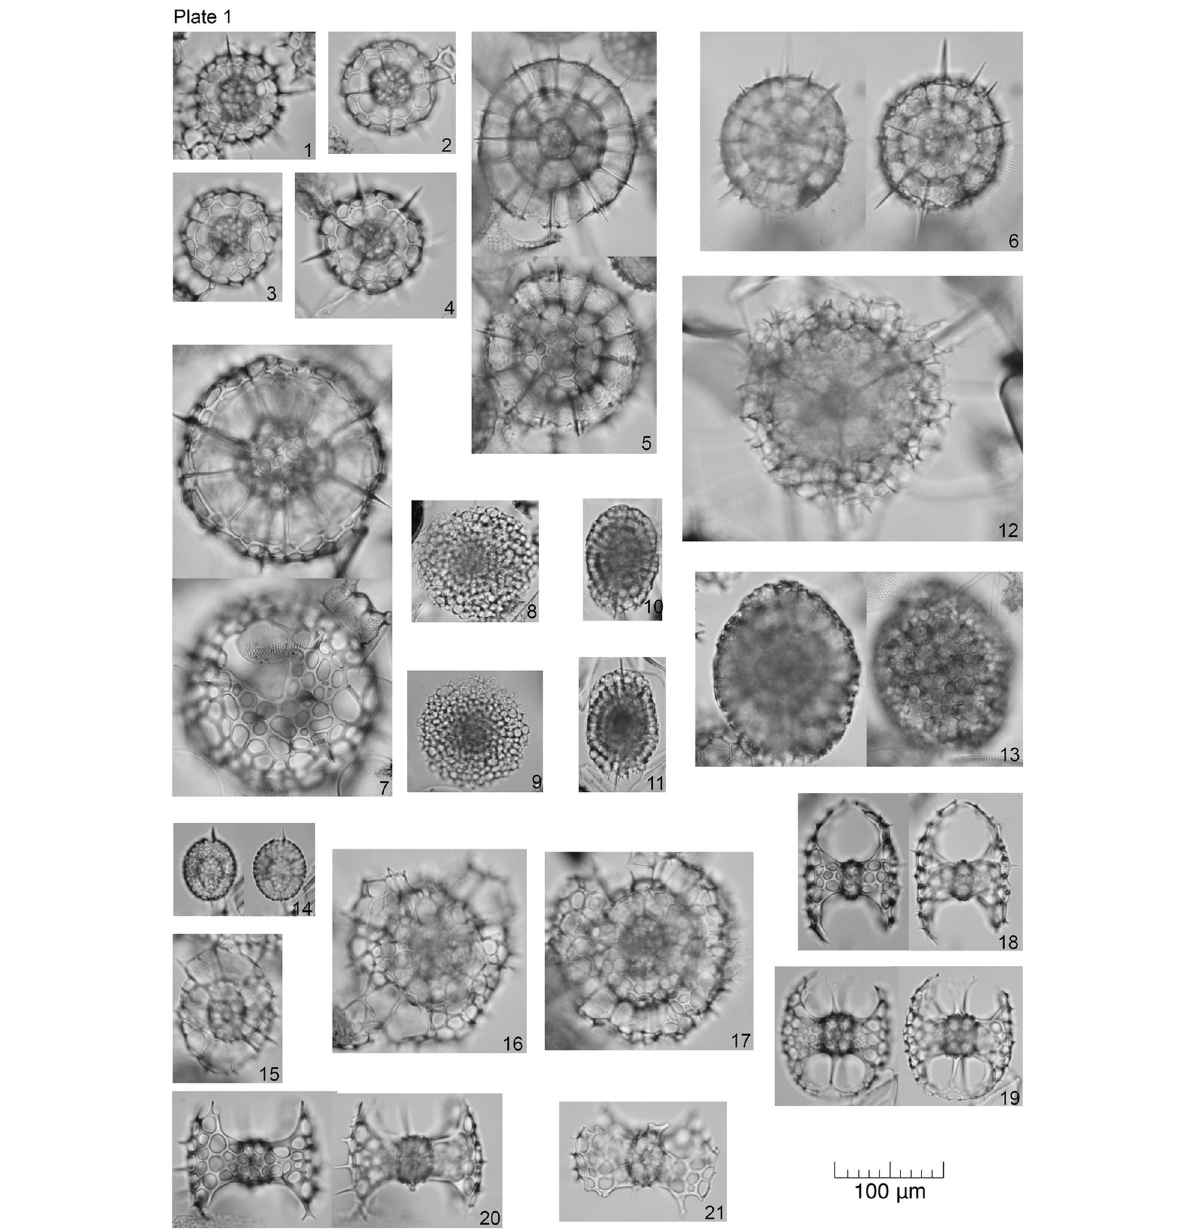
Fig. 2 Key Spumellarian species encountered at Site U1429. 1 – 4 Actinomma leptodermum (Jørgensen) (sample 346-U1429A-7H6-27-29 cm); 5 – 6 Actinomma boreale Cleve (sample 346-U1429A-7H6-27-29 cm); 7 Actinomma medianum Nigrini (sample 346-U1429A-1H1-27-29 cm); 8-9 Spongodiscus cf. resurgens Ehrenberg (sample 346-U1429A-1H1-27-29 cm); 10-11 Larcopyle weddelium Lazarus, Faust and Popova (sample 346-U1429A-7H6-27- 29 cm); 12 Spongosphaera streptacantha Haeckel (sample 346-U1429A-1H1-27-29 cm); 14 Druppatractus irregularis Popofsky (sample 346-U1429A-1H1- 27-29 cm); 15-17 Phorticium polycladum Tan and Tchang (sample 346-U1429A-1H1-27-29 cm); 13 Larcopyle cf. buetschlii Dreyer (sample 346-U1429A- 7H6-27-29 cm); 18 Tetrapyle circularis Haeckel (sample 346-U1429A-7H6-27-29 cm); 19 – 21 Tetrapyle fruticosa (Tan and Chen) (sample 346-U1429A-7H6-27-29